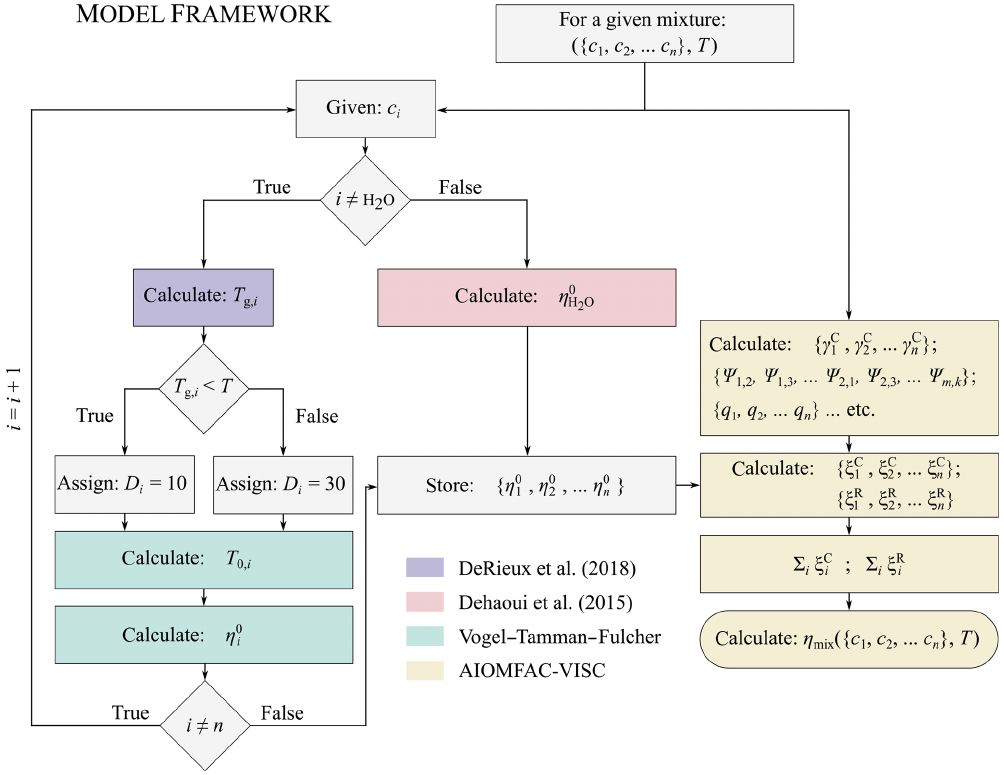
Figure 1. A flow chart showing a simplified schematic of the AIOMFAC-VISC model framework. The colour shadings of the boxes denote the model or parameterization being used at a given point in the framework. Blue indicates the use of the DeRieux et al. (2018) model to predict the pure-component calorimetric glass transition temperature, green indicates the use of the modified Vogel–Tammann–Fulcher equation to predict the pure-component viscosity of the organic components, red indicates the use of the Dehaoui et al. (2015) parameteriza- tion to estimate the pure-component viscosity of water, and yellow indicates the use of AIOMFAC-VISC to calculate the mixture viscosity. The model components shown in blue, green, and red are interchangeable with other methods of calculating the pure-component viscosities. Should more accurate methods of predicting pure-component viscosity become available in the future, the AIOMFAC-VISC framework can be